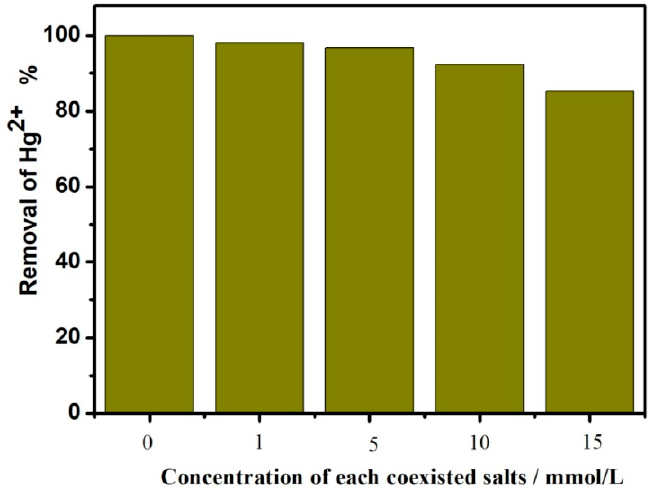
Figure 9. The effect of coexisting ion concentration on adsorption.